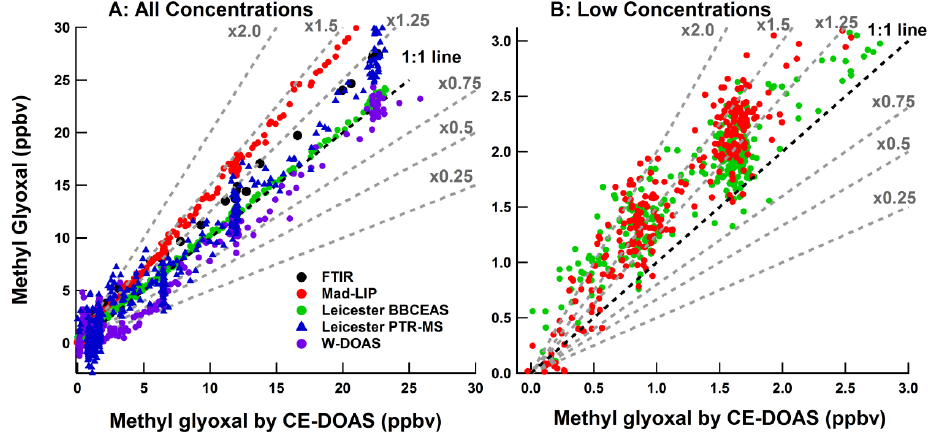
Figure 6. Correlation plots for methyl glyoxal comparison experiment E2. (a) Full range of measured concentrations, while (b) shows only concentrations below 3ppbv. Only data is shown from instruments where the maximum concentration exceeds the LOD (see Sect. 4.2).